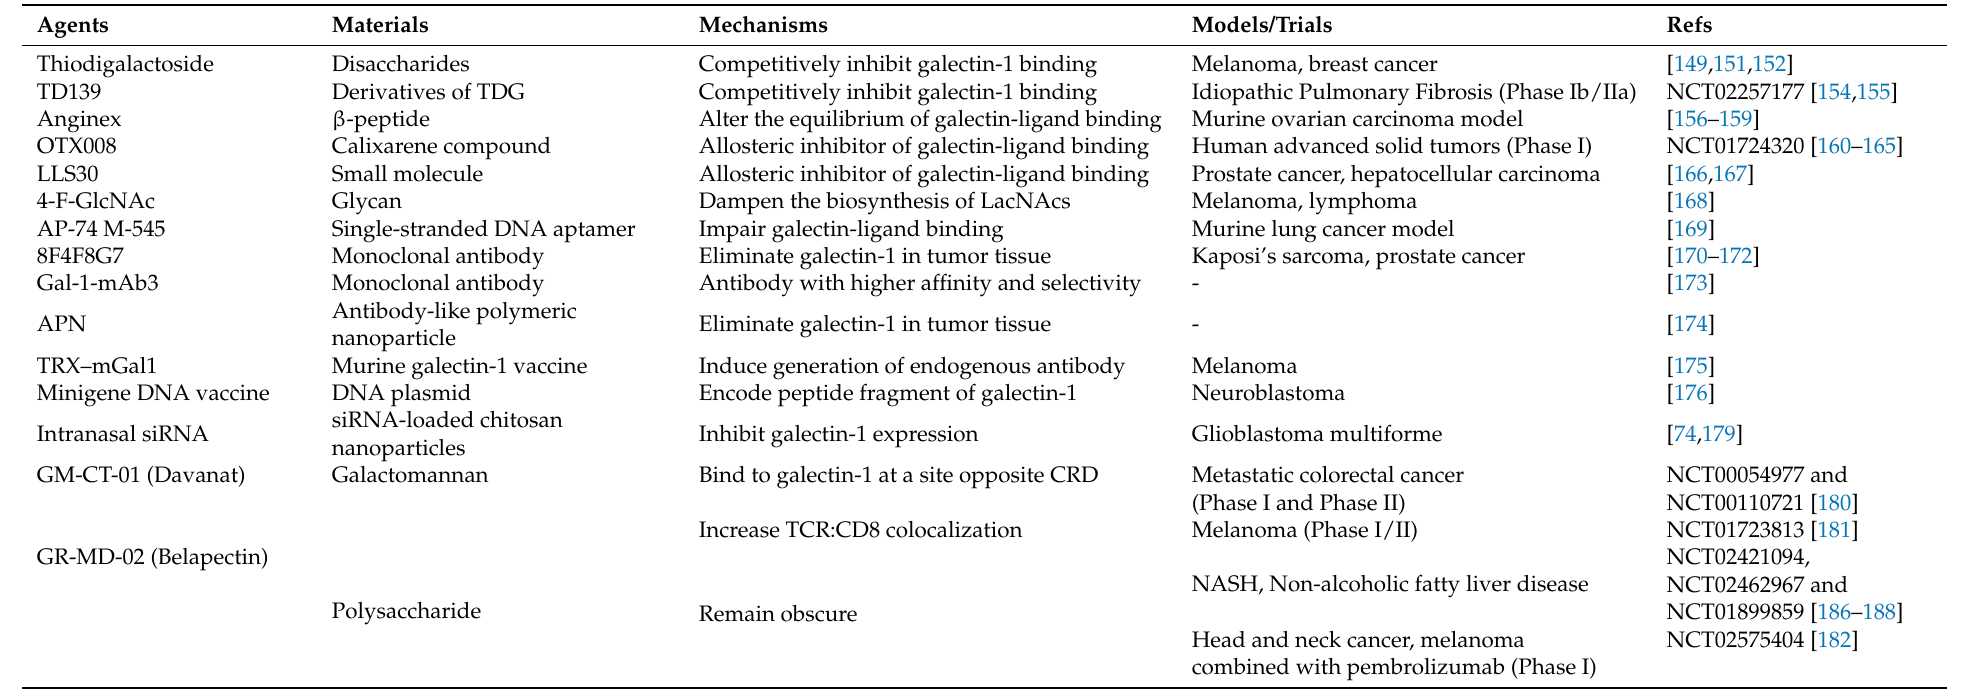
Table 1. Treatments targeting